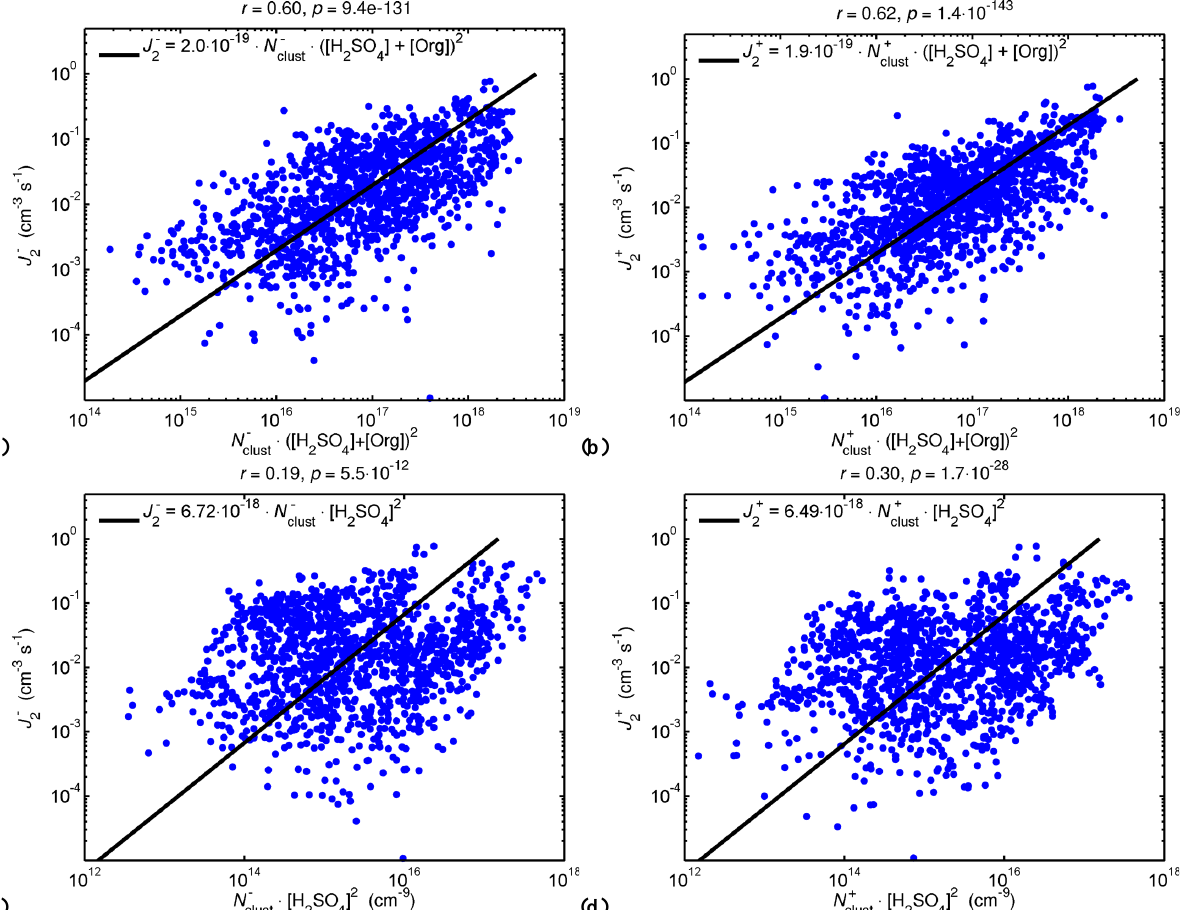
Fig. 2. Ion-induced nucleation rates of (a) negative and (b) positive ions at 2nm, as a function of cluster ion concentration multiplied with the squared sum of sulphuric acid and growth equivalent organic vapour concentrations. The data is measured in Hyyti¨al¨a (May 2007), Hohenpeissenberg (from July 2007 to July 2008), Melpitz (May 2008) and San Pietro Capofiume (July 2009). Panels (c) and (d) show the same J 2 values when leaving out the organic concentration from the parameterizations. Correlation coefficients and corresponding p -values between observed and parameterized values are shown on top of each